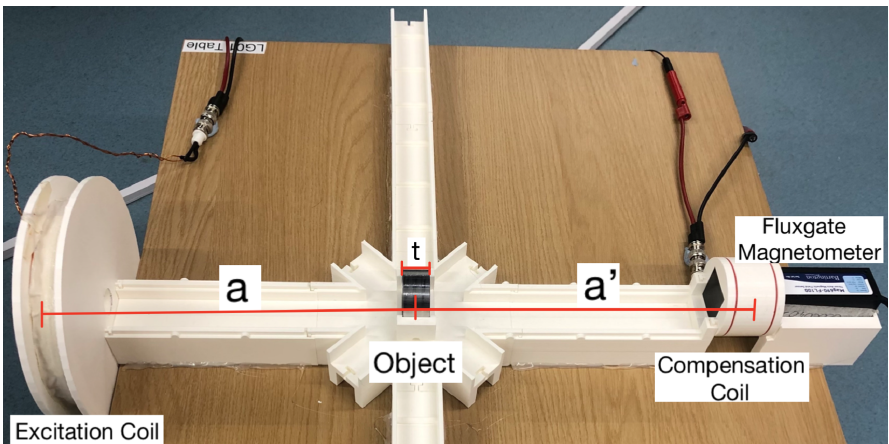
Figure 1. Tabletop active detection system, consisting of an excitation coil, a fluxgate magnetometer, a compensation coil, and an object, of thickness t, which can be placed either on-axis or off-axis. The object is positioned at a distance a from the excitation coil and a distance a’ from the detection point of the